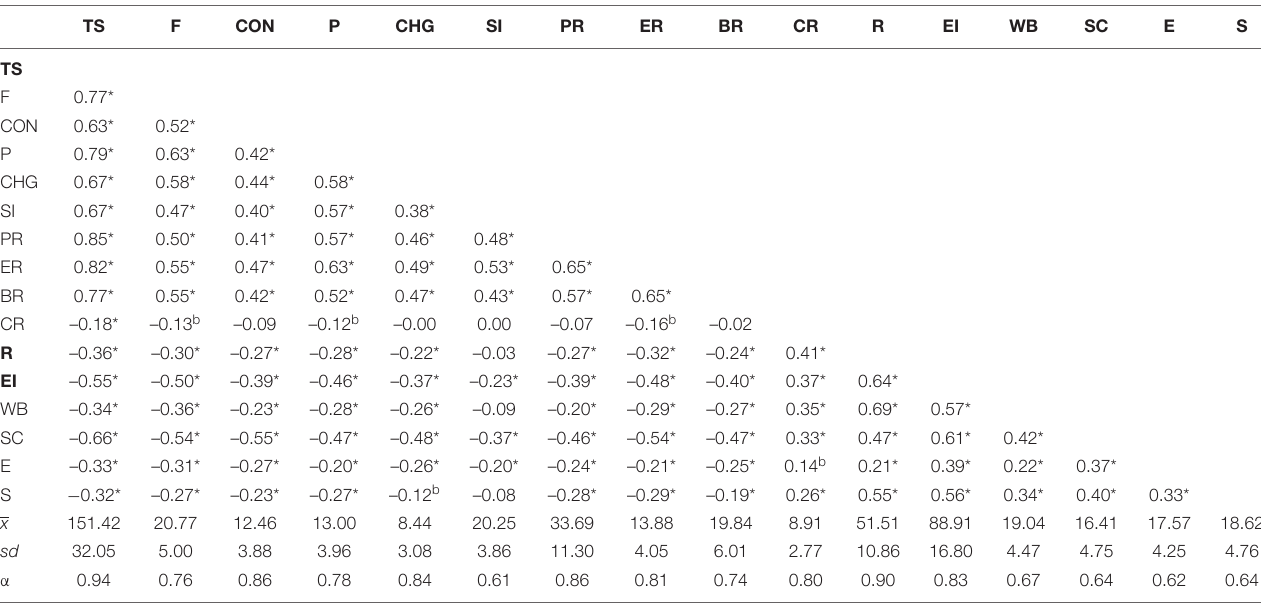
TABLE 1 | Descriptive statistics and correlations between the study variables.